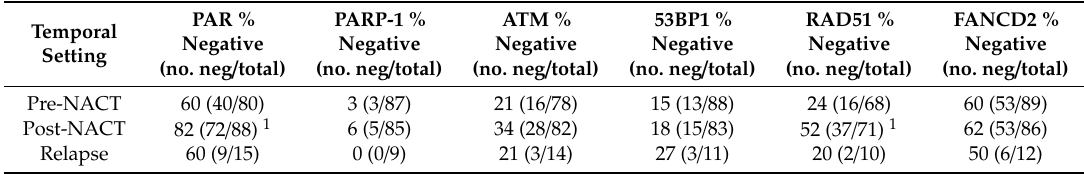
Table 3. DDR markers expression before and after neoadjuvant chemotherapy (NACT) and at